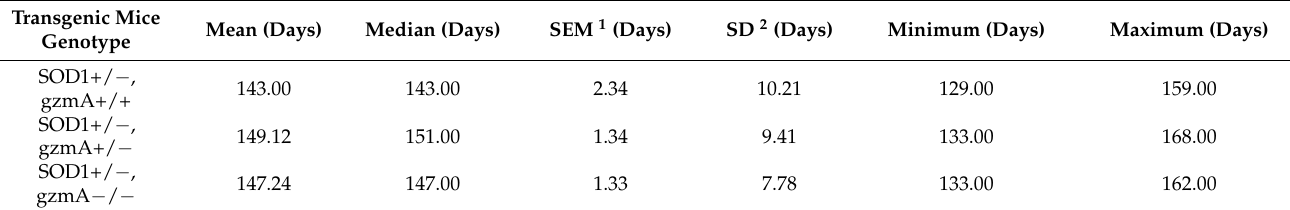
Table 1. Descriptive statistics of the survival analysis for each group of transgenic mice.